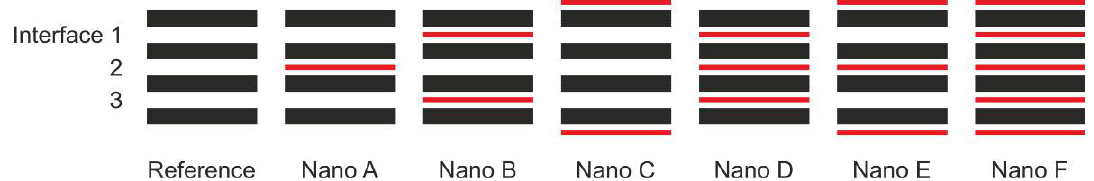
Figure 1. Schematic representation of the different laminate configurations for DMA tests (black lines: CFRP ply, red lines: nanofibrous mat). The nano-modified configurations are replicated for the three different membrane grammages.